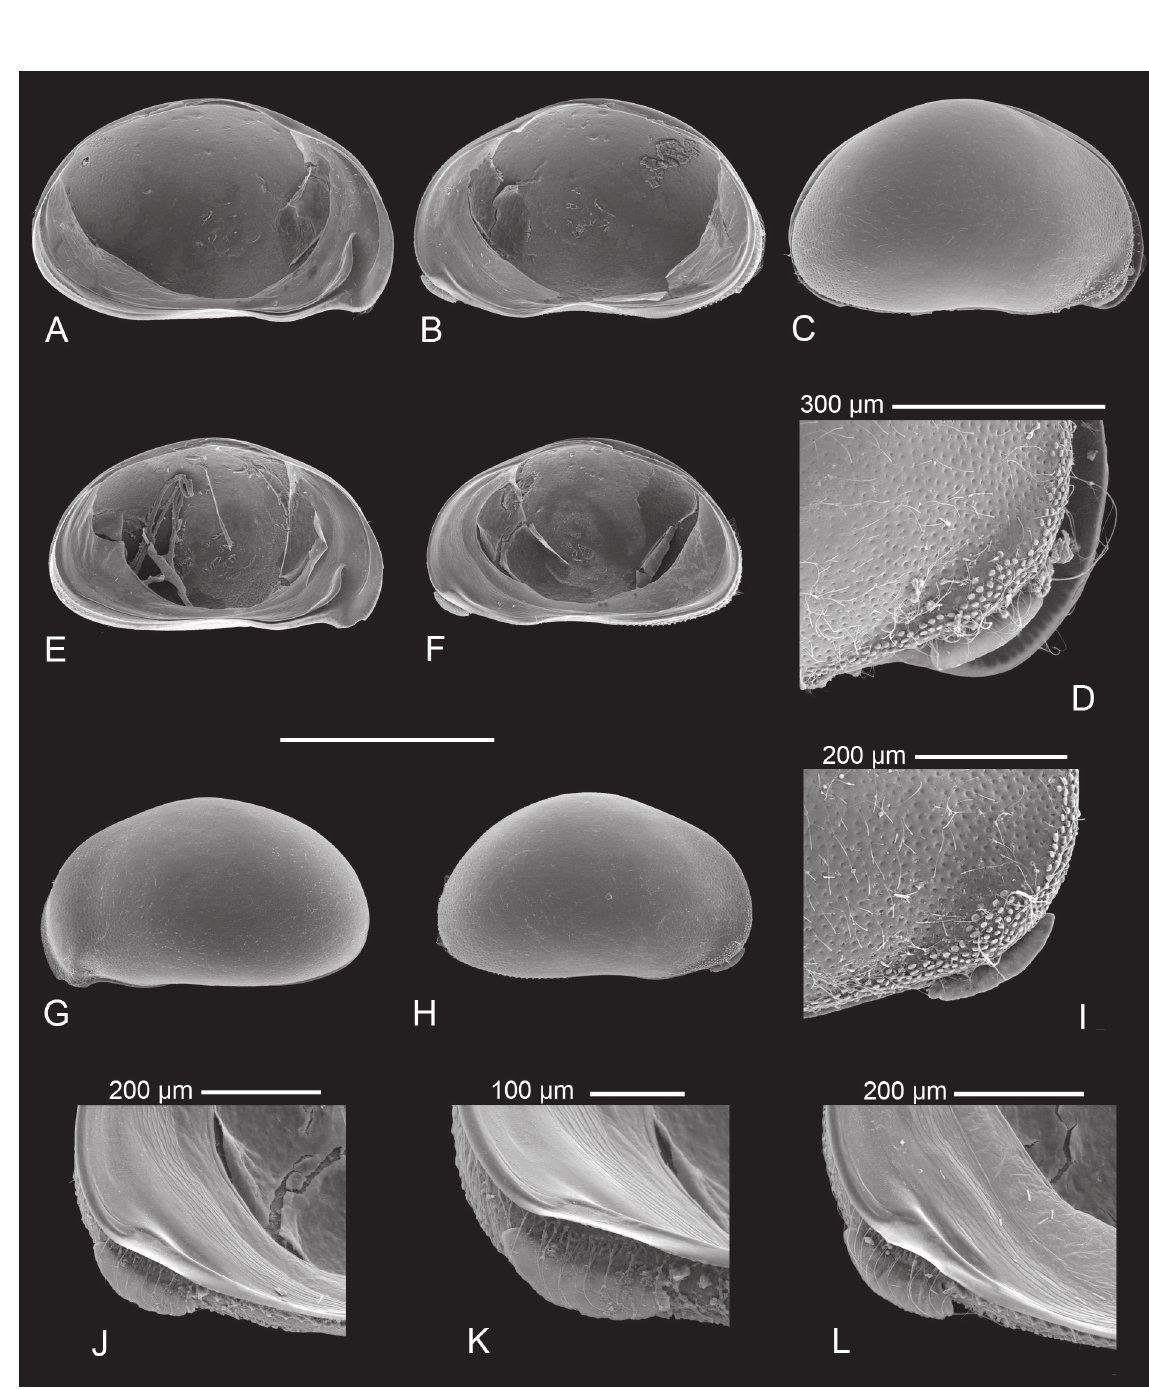
Fig. 16. Bennelongia mcraeae sp. nov., type specimens from type locality (arro lake, Ostr014). A . ♀ allotype, lVi (WaMc52287). B . ♀ allotype, RVi (idem). C . ♀ paratype, CpRL (WAMC52289). D . ♀ paratype, cprl, detail anterior (idem). E . ♂ holotype, LVi (WAMC52286). F . ♂ holotype, RVi (Idem). G . ♂ holotype, LVe (idem). H . ♂ holotype, RVe (idem). I . ♂ holotype, RVe, detail anterior (idem). J . ♂ holotype, RVi, detail anterior (idem). K . ♂ holotype, RVi, detail anterior, tilted (idem). L . ♀ allotype, rVi, detail anterior, tilted (WaMc52287). scales = 1 mm unless otherwise